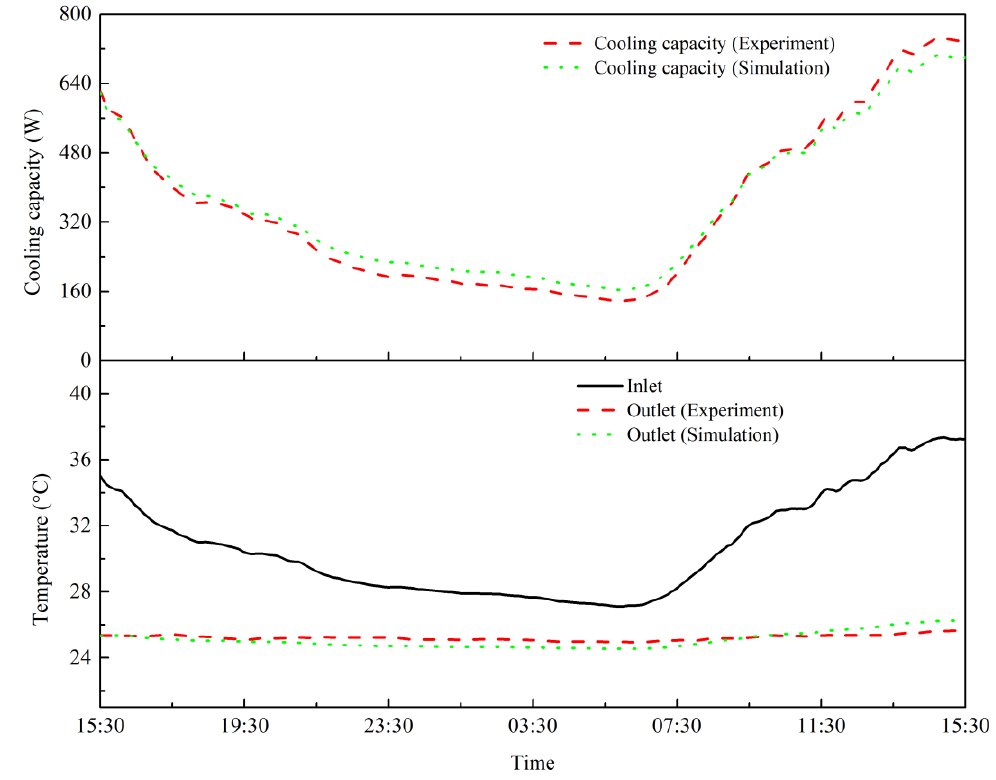
Figure 5. The comparison between experiment and simulation data for outlet air temperature and cooling capacity.